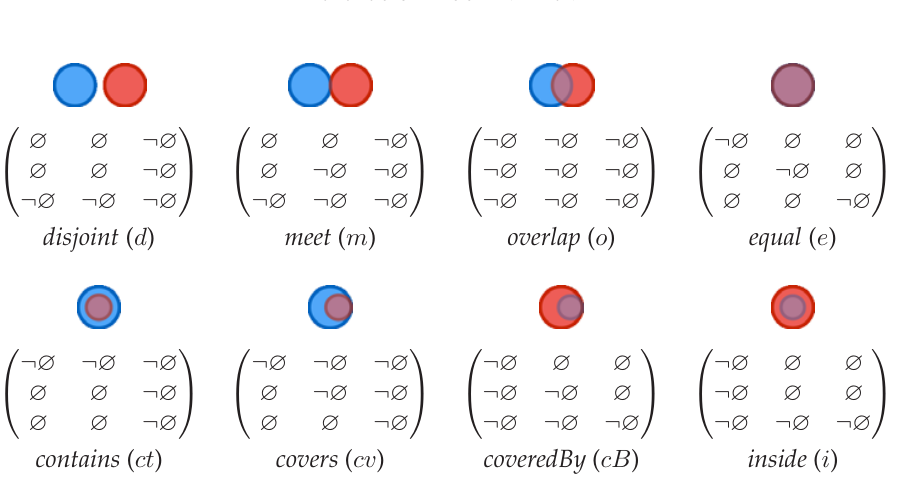
Figure 6: The eight topological relations identified by the 9 -intersection between two simple regions [23].